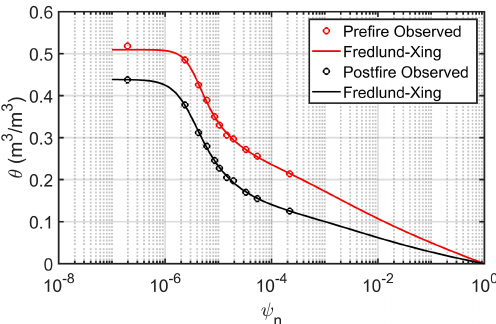
Figure 1. Pre- and postburn water retention curves at the 2004 Man- itou Experimental Forest (MEF) burn site. Observations were fit- ted with the Fredlund and Xing (1994) model. The only difference between these two curves is that the total or air-filled porosity is about 0.51 for the preburn (red), and it is about 0.45 for the post- burn